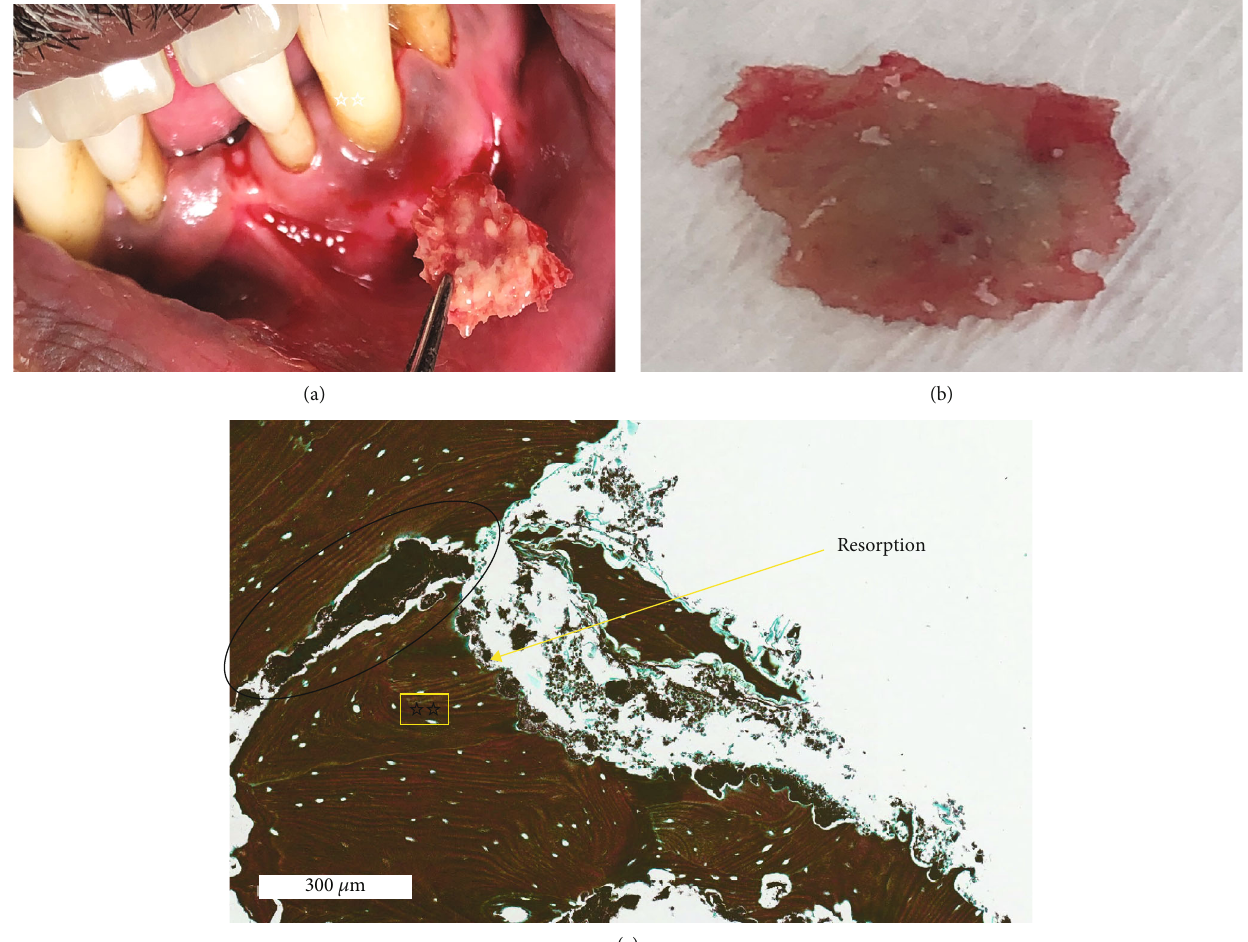
Figure 4: (a, b) Intraoral photograph after bone removal. (c) Necrotic bony trabeculae with actinomycosis fi laments on the trabecular surface (black circle) and extensive sclerosis of bone showing prominent resting and reversal lines ( ∗∗